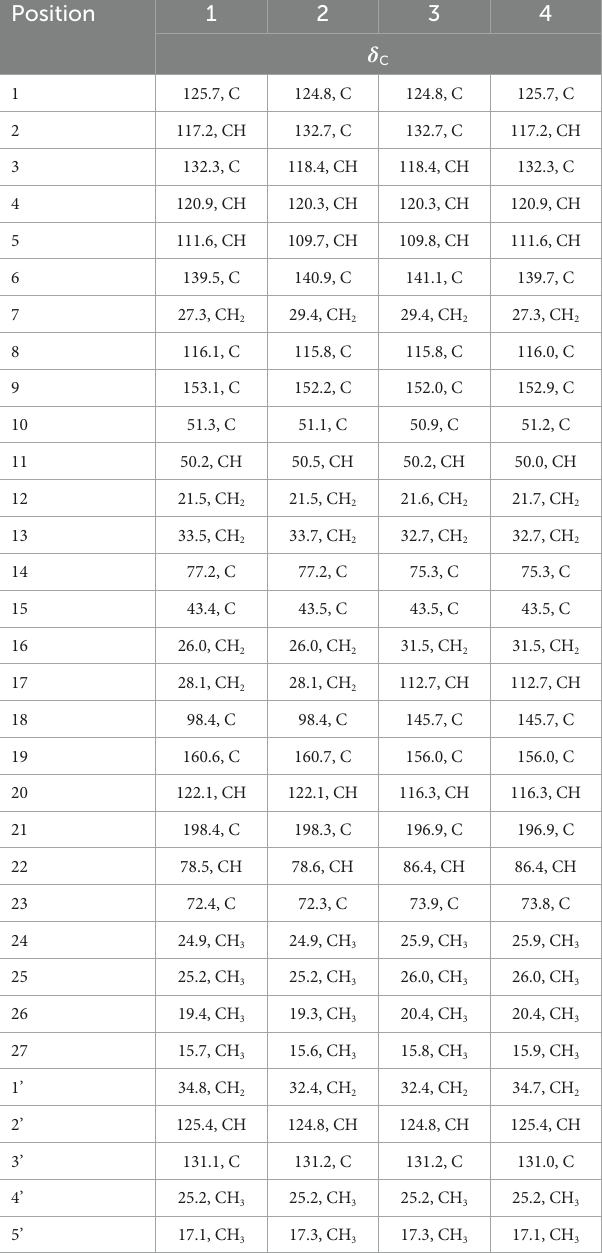
TABLE 1 The 13 C NMR (100 MHz) data of compounds, 1-4 in CD 3 OD.